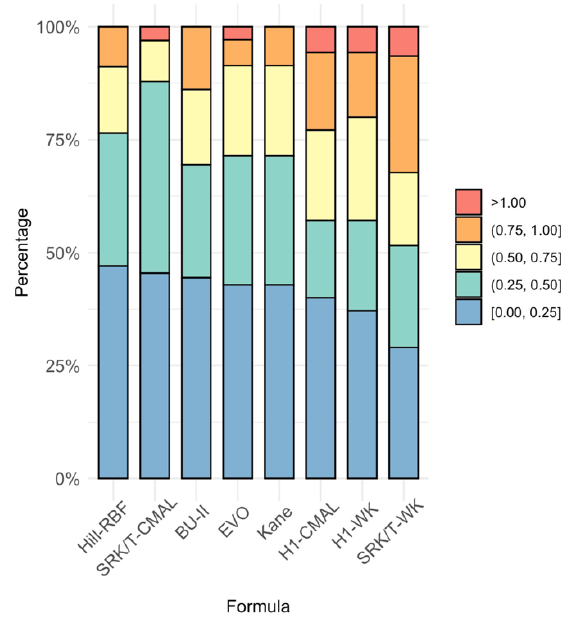
Figure 2. Stacked histogram comparing the percentage of eyes within ±0.25 diopters (D), ±0.50 D, ± 0.75 D, and ± 1.00 D of predicted spherical equivalent for various intraocular lens calculation formulas. BU-II = Barrett Universal II; CMAL = Cooke-modified axial length; EVO = Emmetropia verifying optical; H1 = Holladay 1; WK = Wang–Koch AL adjustment.